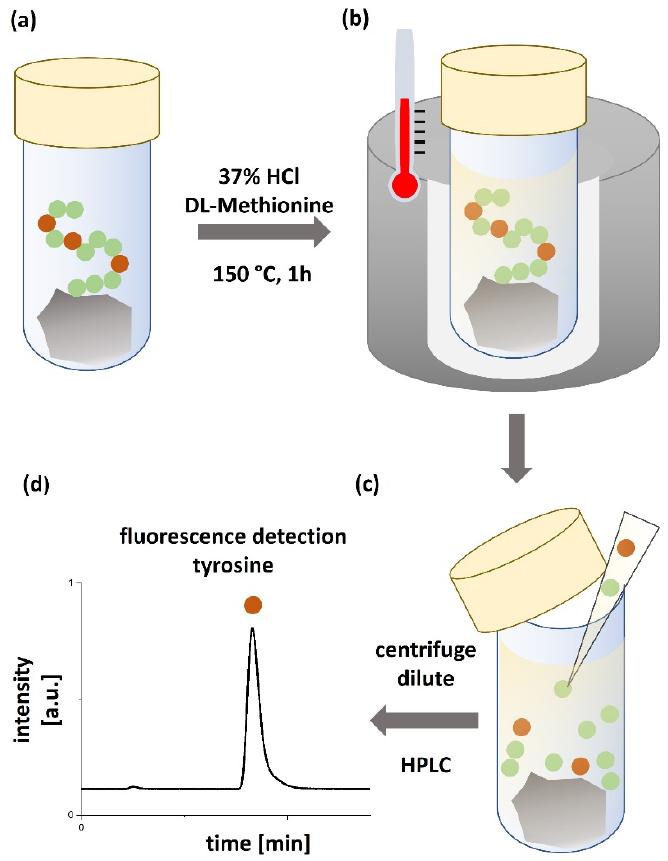
Figure 4. Workflow of aromatic amino acid analysis (AAAA) of protein-functionalized corundum. Red dots symbolize aromatic amino acids in the sequence, green dots all other amino acids: ( a ) Protein bound to corundum particles, ( b ) hydrolysis in HCl at 150 °C for 1 h, ( c ) dilution of hydrolysis supernatant, and ( d ) HPLC analysis of tyrosine with fluorescence detection (excitation 272 nm/emission 303 nm).